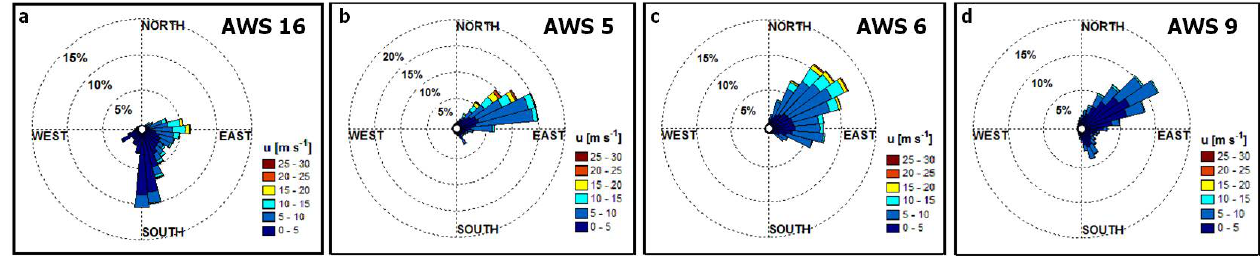
Fig. 9. Dominant wind directions measured at (a) AWS 16 – Princess Elisabeth, (b) AWS 5 – Wasa/Aboa, (c) AWS 6 – Svea Cross and (d) AWS 9 – Kohnen. The contribution of each wind speed class to a given wind direction is shown in the colour scale.